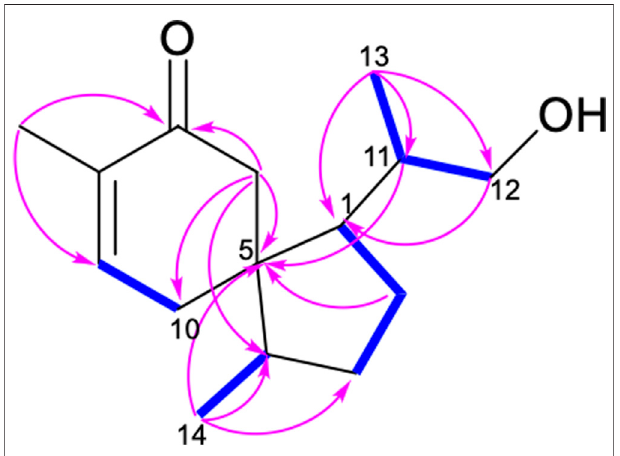
FIGURE 2 | Key COSY (bolds, blue) and HMBC (arrows, pink) correlations of 1.